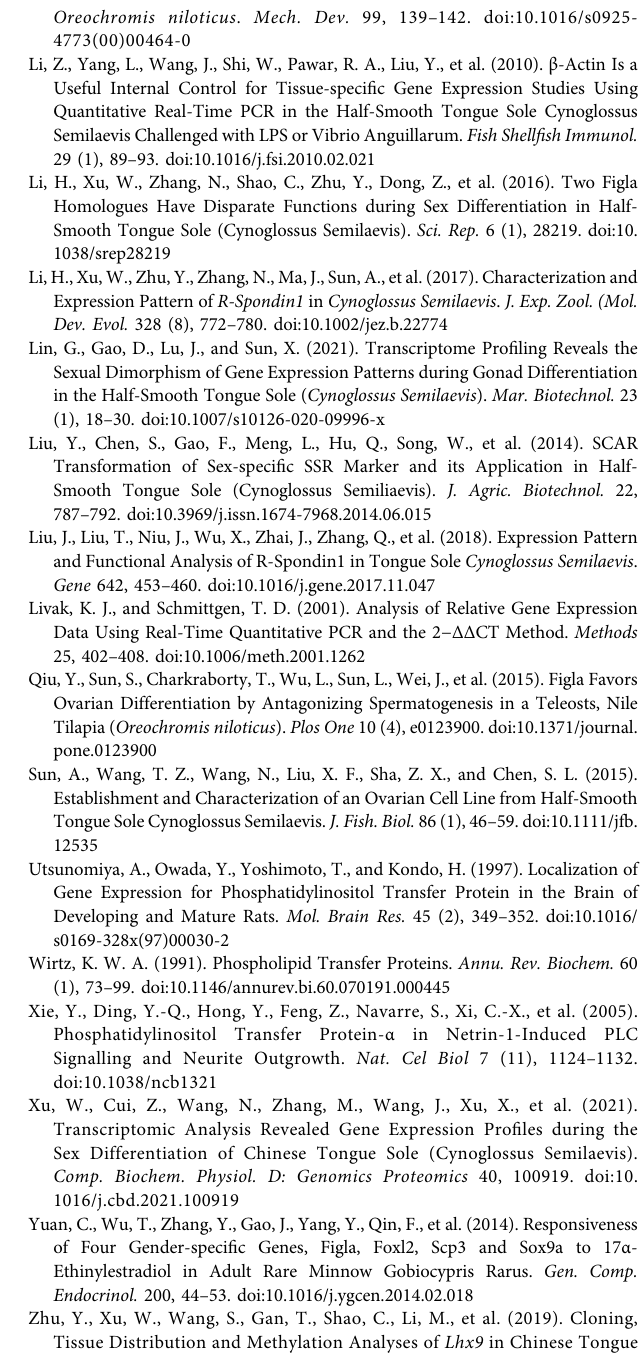
Supplementary Figure S1 | Alignment of the three Pitp β in Chinese tongue sole. Depending on different extents of conservation, the sites are labelled in black, grey, and